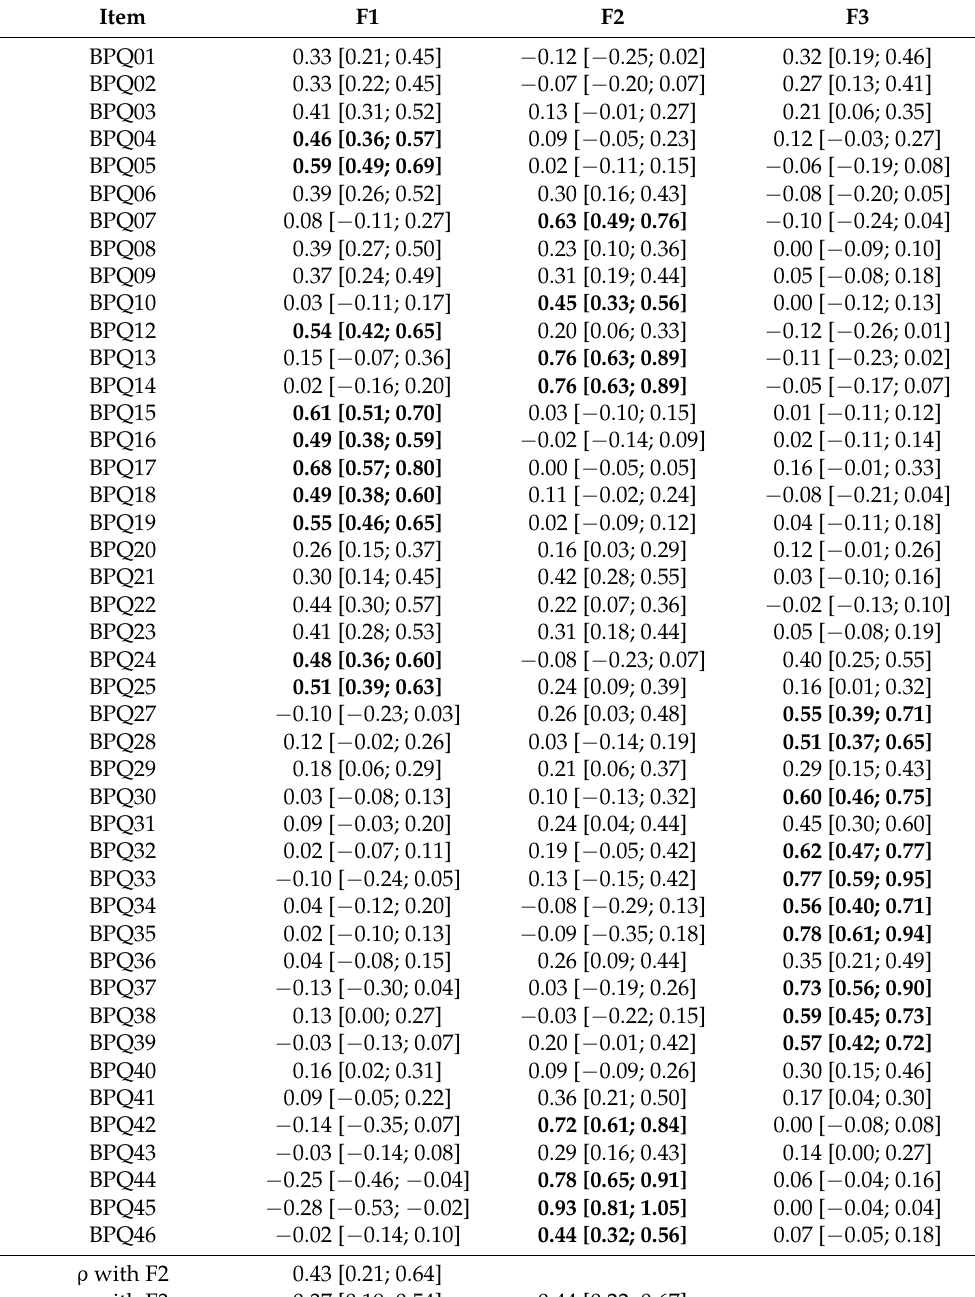
Table 1. Loading matrix and factor correlations of the three-factor exploratory structural equation modeling